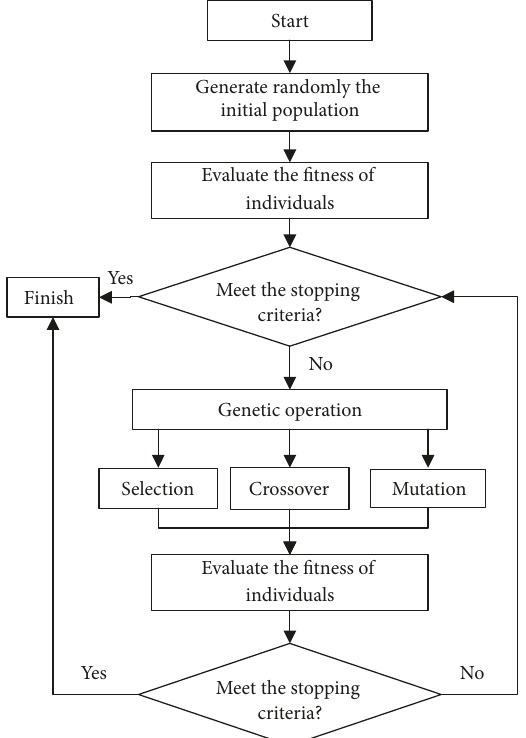
Figure 5: Chart of genetic algorithm.